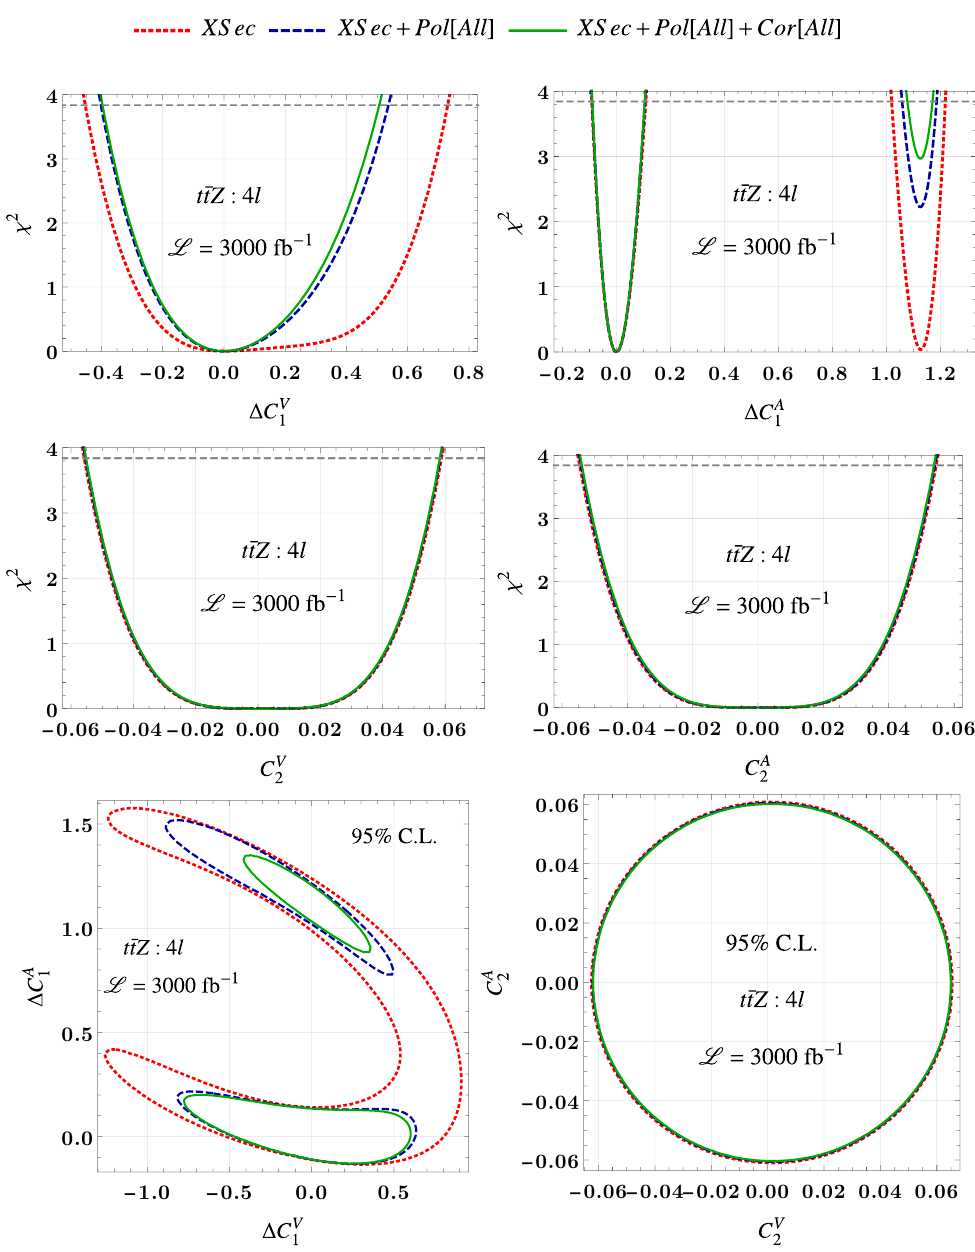
Figure 8 . The χ 2 for cross section ( XSec ), all polarizations ( Pol [ All ] ) and spin correlations and their combinations are shown as a function of t ¯ tZ anomalous couplings one at a time. The dashed horizontal lines at χ 2 = 3 . 84 in the upper two rows indicate the 95% C.L. bound on the couplings. The bottom-panels show the 95% C.L contours for the above same combination of the observables. √ The plots are shown for s = 13 TeV and integrated luminosity L = 3000 fb − 1